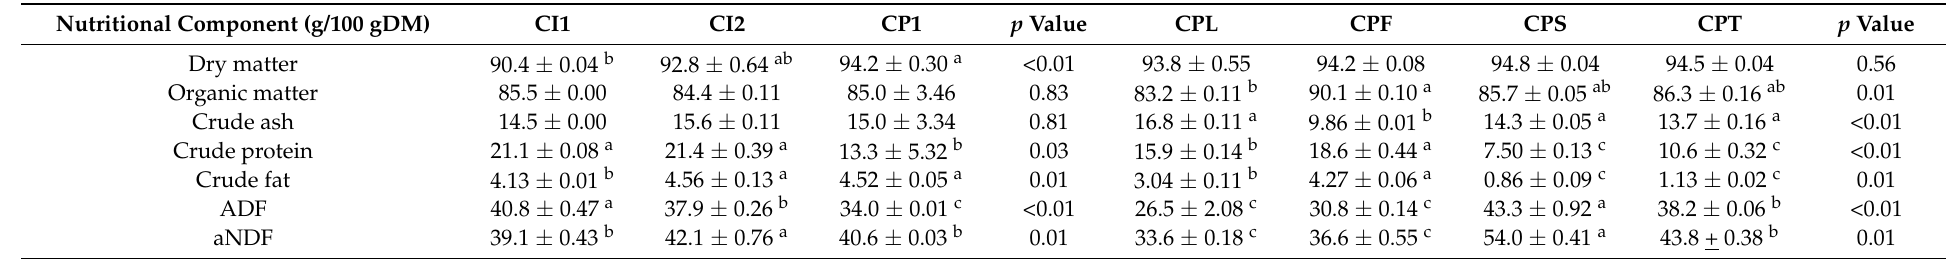
Table 3. Primary chemicals content in Coleus amboinicus Lour. cultivated in Indonesia (CI1 and CI2) and in Poland (CP1) samples) and separately sample from leaves (CPL), flowers (CPF), stems (CPS), and twigs (CPT) of plants cultivated in Poland ( n = 3, mean value ± SD). Values marked with the same superscript letters in rows, are not significantly different at p ≤ 0.01. Nutritional Component (g/100